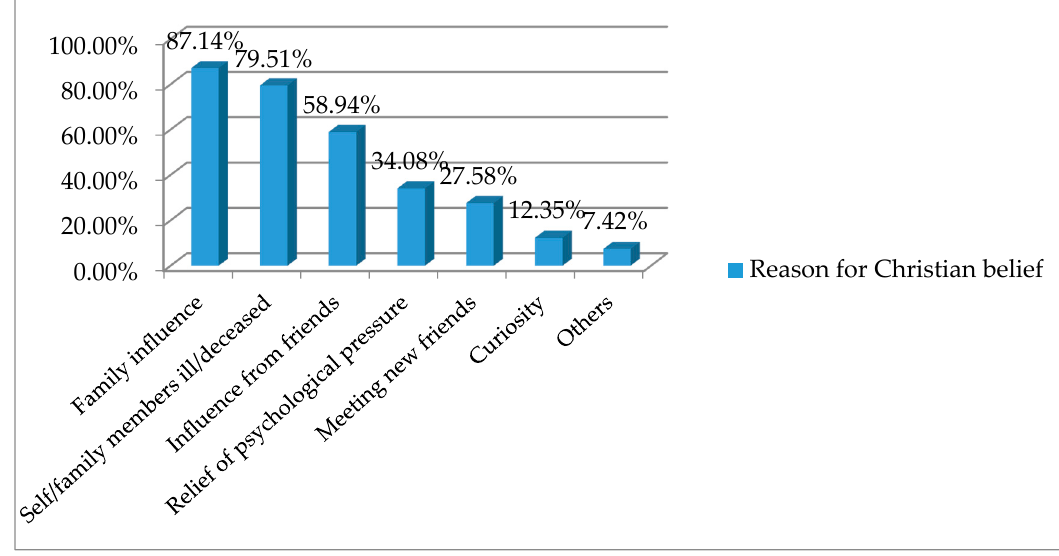
Figure 2. The cause why people become a member of Christianity.